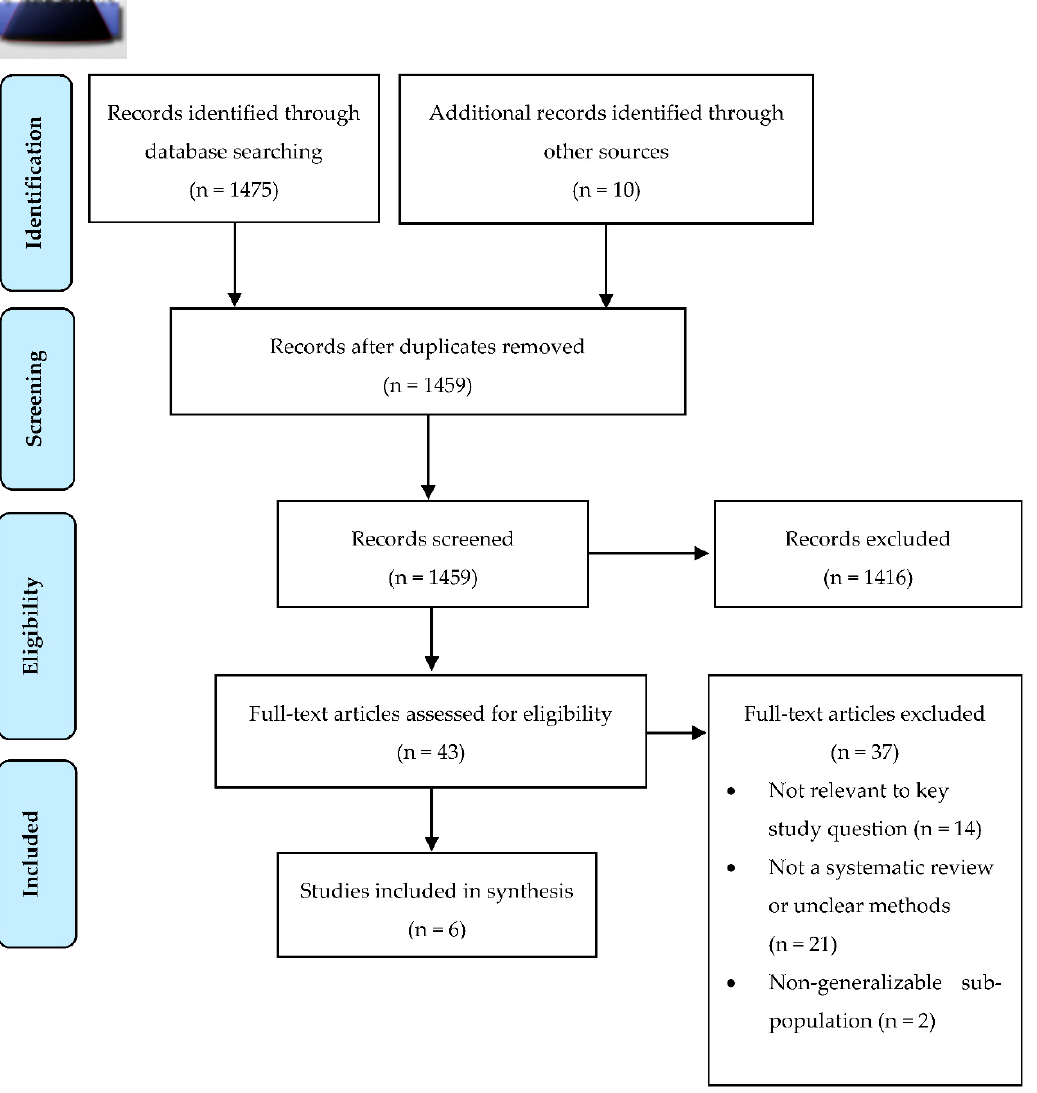
Figure 1. Preferred Reporting Items for Systematic Reviews and Meta-Analyses (PRISMA) diagram for the effectiveness of hepatitis C screening.